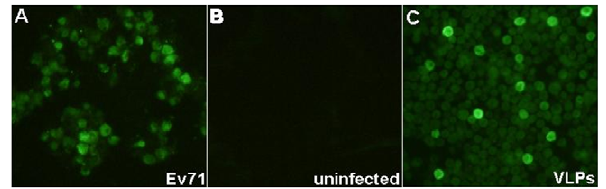
Figure 2. Characterization of Mab 1C6. Cells were labeled with Mab 1C6 followed by anti-mouse FITC secondary antibody. (A) Vero cells infected with EV71-B5 (NUH0083). (B) Non-infected Vero cells. (C) Insect cells expressing virus-like particles (VLPs) of EV71.